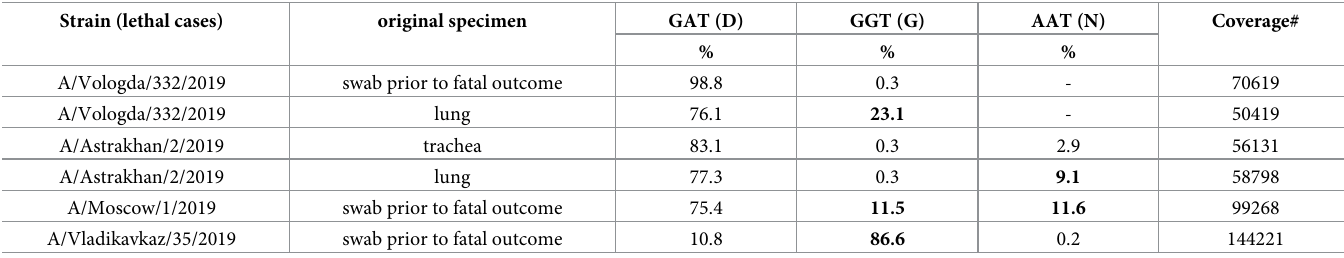
Table 5. HA 222D/G/N polymorphism in the A(H1N1)pdm09 viruses in different parts of the respiratory system. Strain (lethal